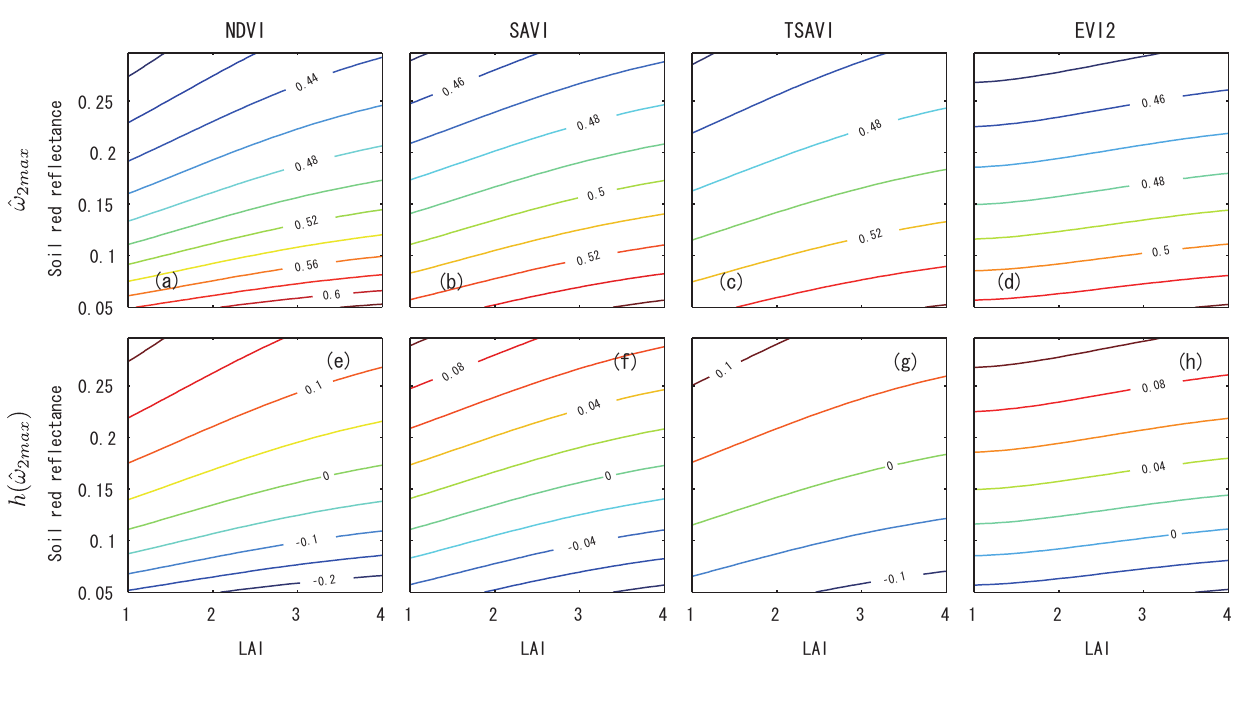
) as a function of spectrum of vegetation and and h (^ ω 2 max 2 max ) . 2 max